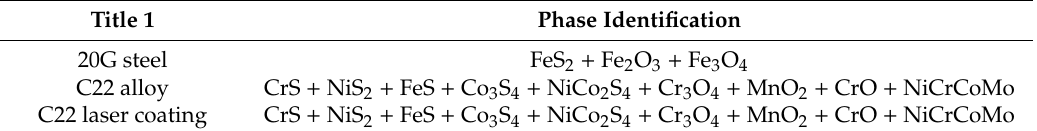
Figure 8. XRD patterns of corrosion products of 20G steel, C22 alloy and C22 laser coating corroded in reducing atmosphere for 108 h at 450 ◦ C. Table 4. Phase constitution of corrosion products 20G steel, C22 alloy and C22 laser coating corroded in reducing atmosphere for 108 h at 450 ◦